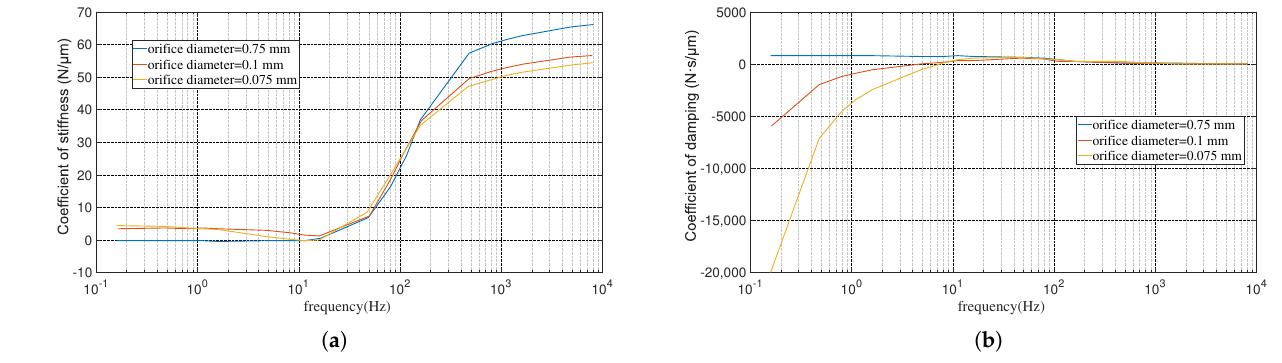
Figure 5. The dynamic characteristics of the gas film under different orifice diameters [9] (gas film thickness = 15 µ m, gas supply pressure = 4.8 Mpa). ( a ) Change of dynamic stiffness with orifice diameter. ( b ) Change of damping with orifice diameter. Reprinted with permission from ref. [9]. Copyright 2022